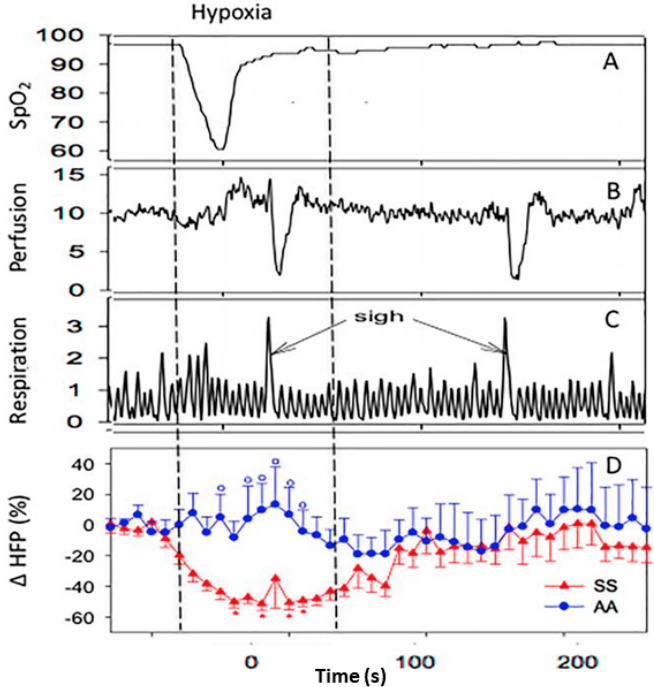
Figure 2. Experimental exposure to five breaths of 100% nitrogen caused desaturation similar to what can happen during sleep. Panels show change in oxygen saturation ( A ), finger blood flow ( B ), respiration ( C ) in a single sickle cell disease (SCD) subject, and change in average parasympathetic activity (cardiac high frequency power; HFP) in 11 SCD and 14 control subjects ( D ). Hypoxia resulted in significant parasympathetic nervous system withdrawal in SCD subjects, but not in controls ( D ). Hypoxia was not associated with a decrease in microvascular perfusion. However, periodic episodes of vasoconstriction ( B ) occurred at about 3.8 s after 78% of sighs ( C ) in SCD subjects versus only 17% in controls ( p < 0.001). From [36] with permission.